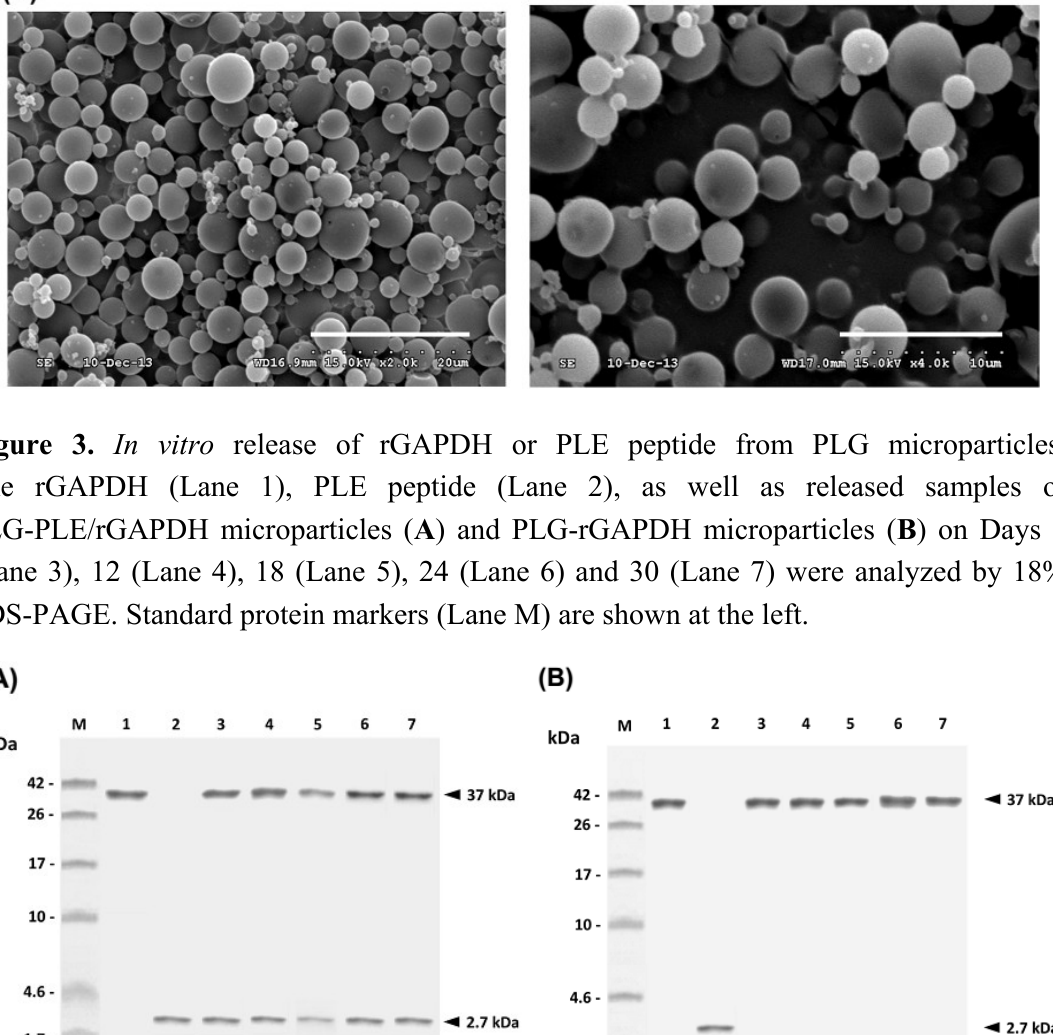
2. Scanning electron micrographs of PLG-encapsulated microparticles. poly(Lactide-co-glycolide) (PLG)-pleurocidin (PLE)/rGAPDH microparticles ( A ) and